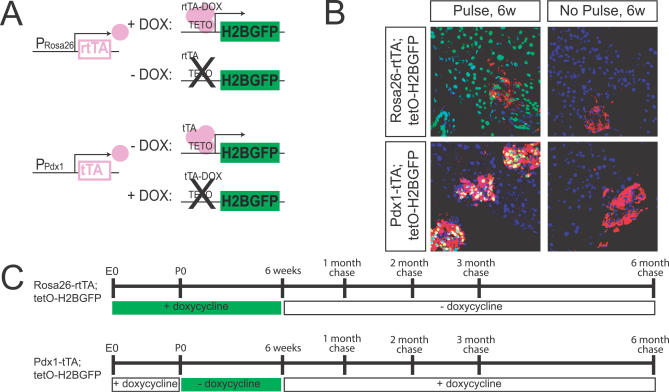
Experimental Schematic for Use of Tetracycline-Inducible H2BGFP To Identify LRCs In Vivo(A) Schematic for Rosa26-rtTA; tetO-H2BGFP and Pdx1-tTA; tetO-H2BGFP expression.(B) Doxycycline-dependent expression of Rosa26-rtTA; tetO-H2BGFP and Pdx1-tTA; tetO-H2BGFP expression in the pancreas. Insulin expression is shown in red. Up to 80% of ß cells are labeled following the pulse period; no ß cells are labeled in the absence of pulse. Original magnification, 400×.(C) Timeline for Rosa26-rtTA; tetO-H2BGFP and Pdx1-tTA; tetO-H2BGFP pulse–chase experiments.